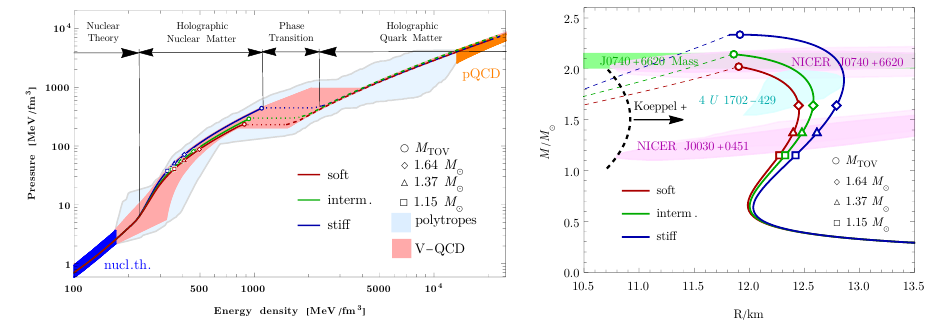
Figure 1. Left: Cold, beta equilibrium slices of the V-QCD EOS. Shown are the soft (red), intermediate (green) and sti ff (blue) versions of the model. Right: Corresponding mass-radius relations where dashed lines mark unstable quark matter branches. See [26] for